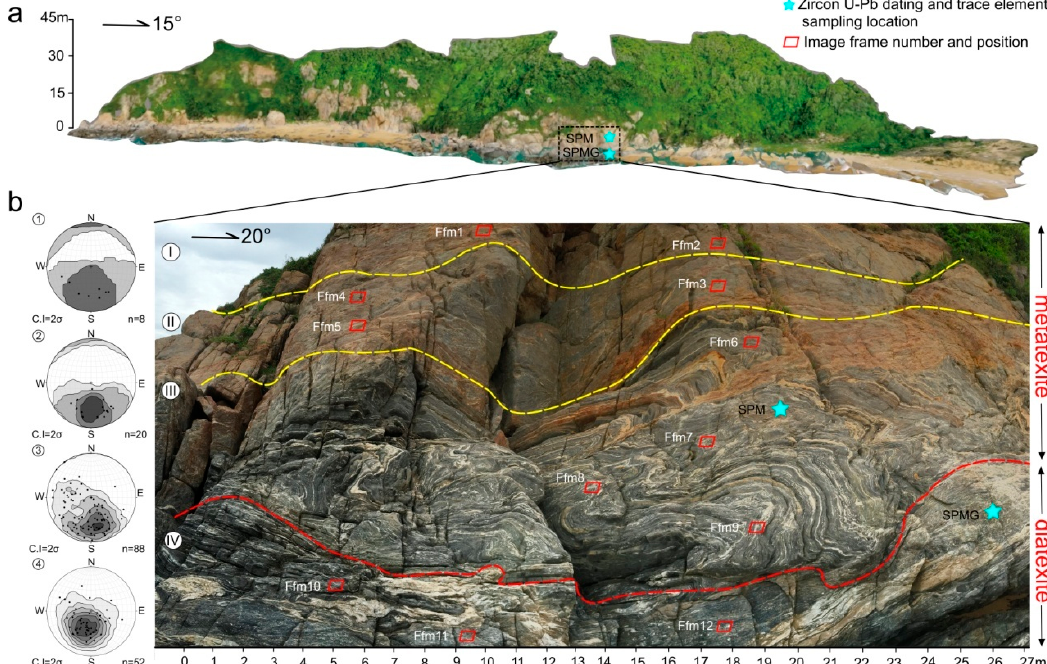
Figure 3. Profile of the Fuhuling metatexite–diatexite transition. ( a ) 3D image of the beach at the southeast of Fuhuling taken by an unmanned aerial vehicle. The location of the metatexite–diatexite profile is marked by the black dashed line box, and the sampling positions for zircon U-Pb geochronology are marked by stars. ( b ) Metatexite–diatexite profile in which the yellow and red dashed lines are boundaries between layer I, layer II, layer III, and layer IV. Red boxes mark the position of leucosome proportion measurements and are numbered by Ffm1–12. Stars mark the positionsof samples for zircon U-Pb geochronology. ① , ② , ③ , and ④ on the left are the layer I, II, III, and IV stereonets of structural data, which show changes in leucosome orientations from metatexite to diatexite. Kamb contours of the structural data are shown with 2 σ contour intervals. The software Stereonet version 6.3.3 by Richard Allmendinger was used for the equal-area stereographic projections. (http://www.geo.cornell.edu/geology/faculty/RWA/programs.html). Layer I is a metatexite with ~5 area % (inferred to be equivalent to vol. %) of